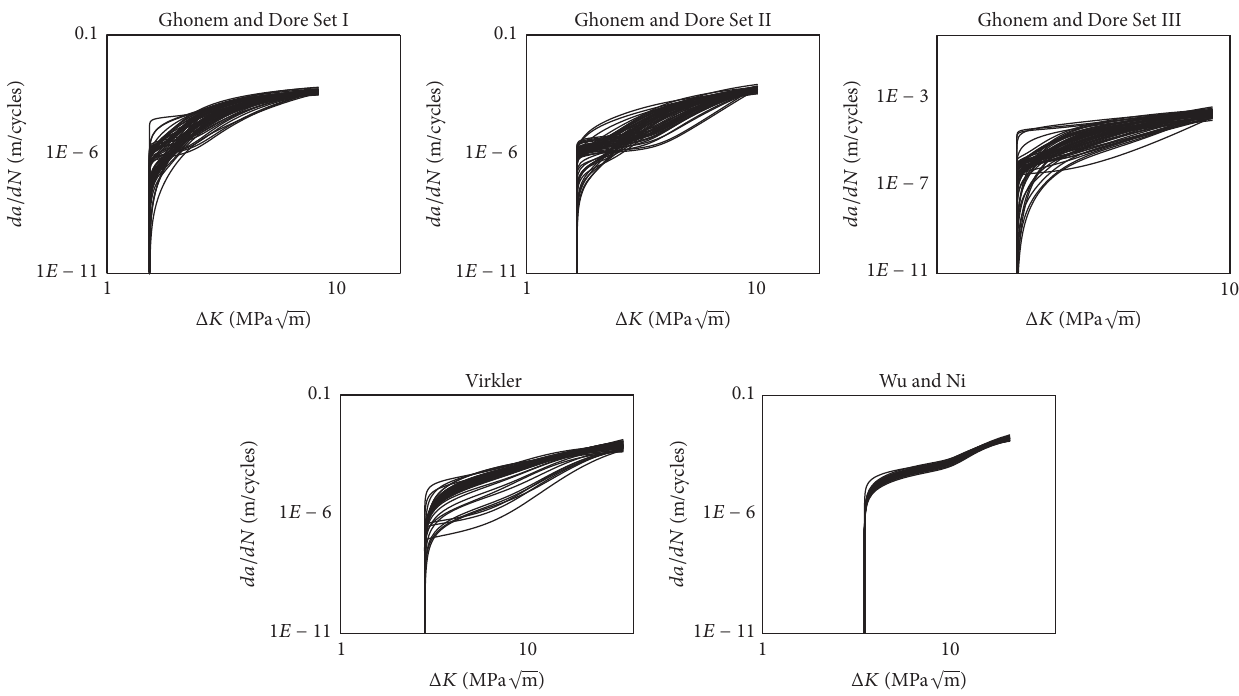
Figure 5: FCG curve for the five